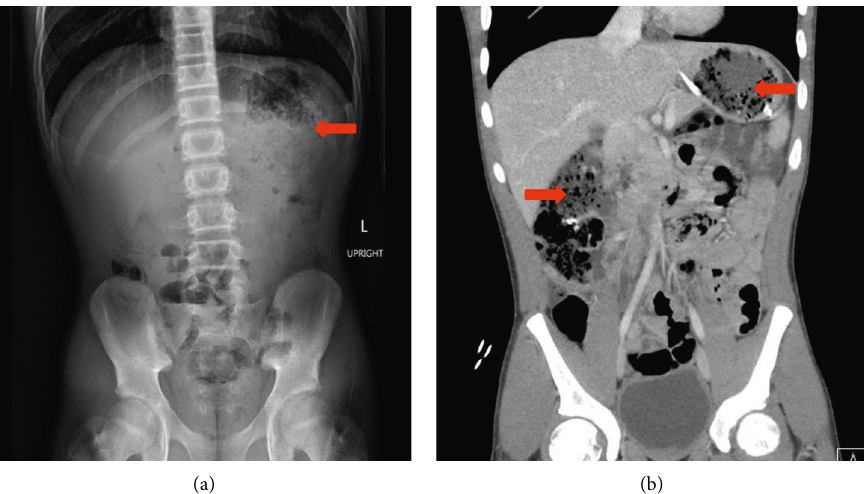
Figure 1: (a) Abdominal X-ray showing large amount of intra-gastric ingested material. (b) CT abdomen (coronal view) showing intra- gastric bezoar without gastric obstruction with similar contents in the proximal small bowel and ascending colon (red arrows).